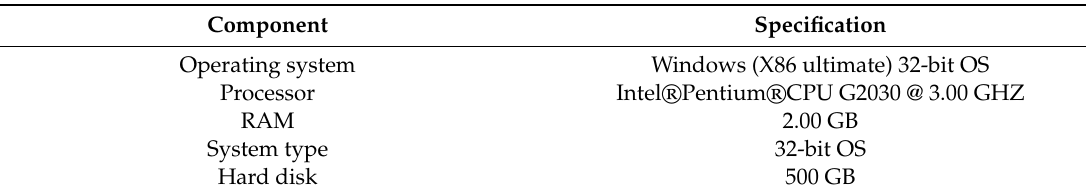
Table 1. Hardware requirements.